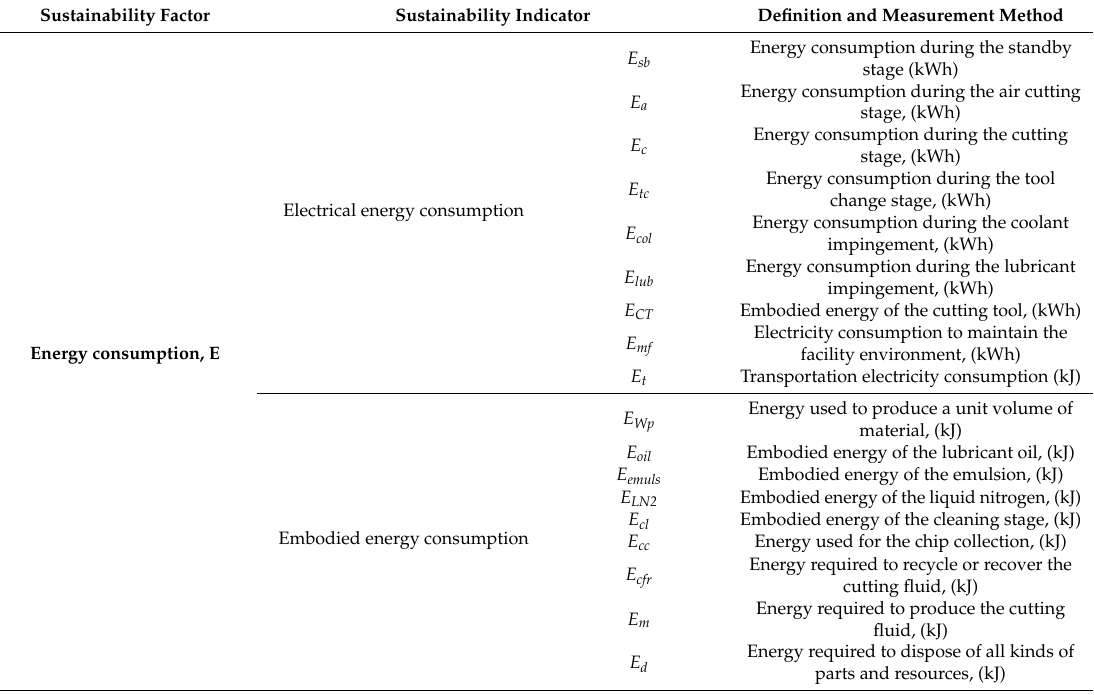
Table 1. Types of electrical and embodied energy consumptions and their